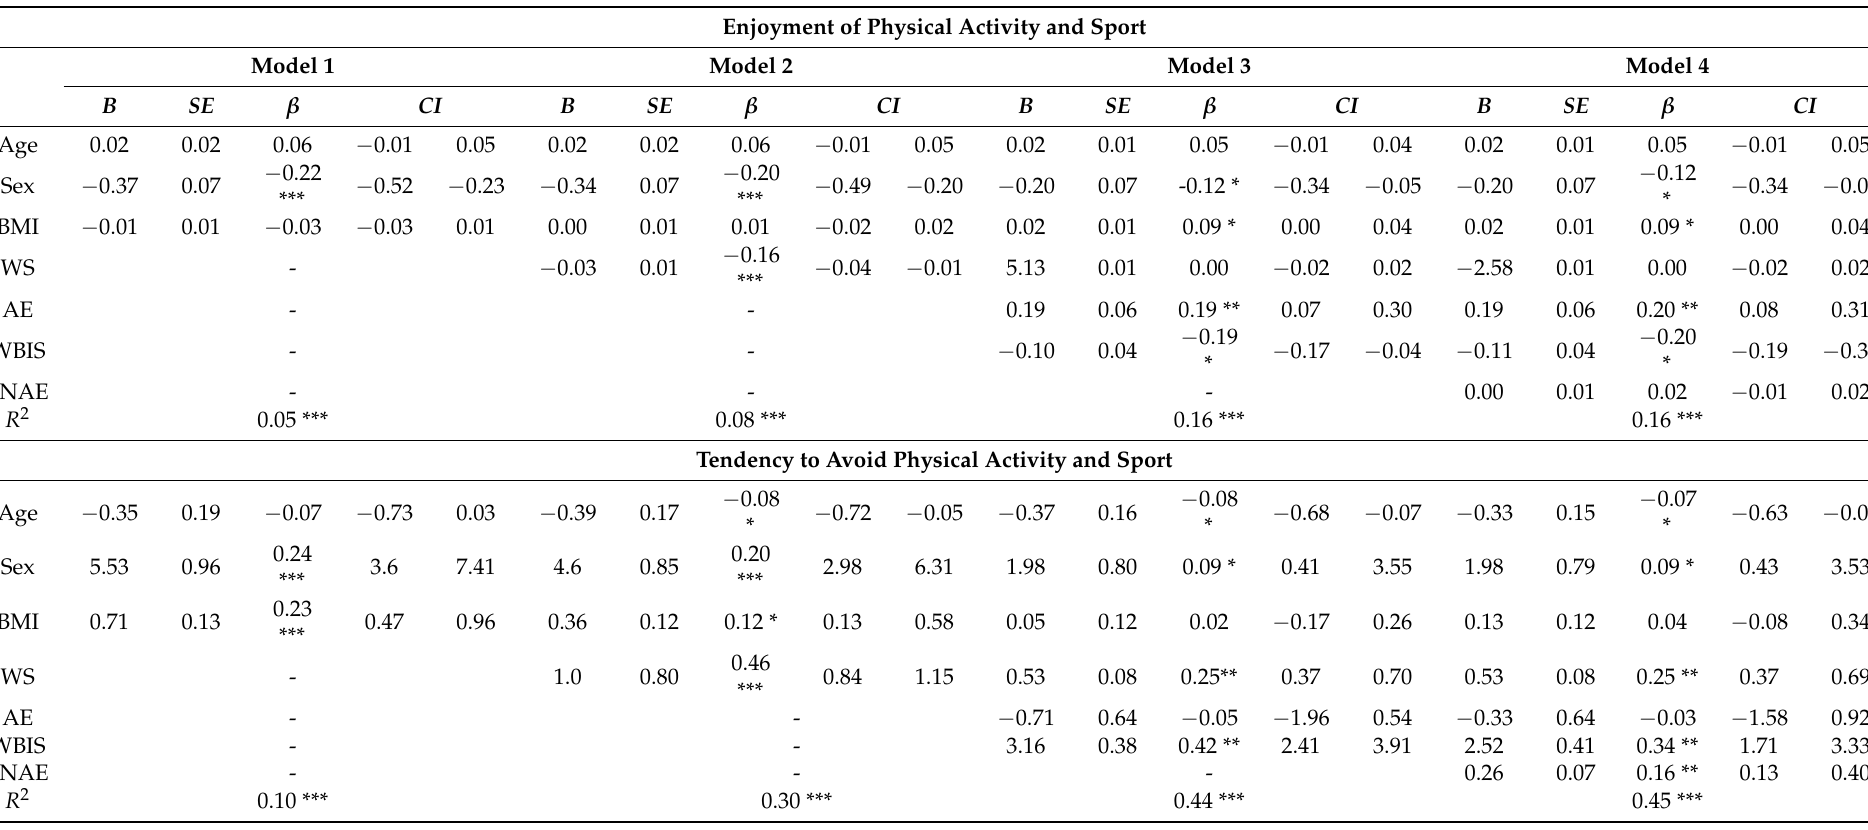
Table 3. Regression models reporting unstandardized ( B ) and standardized beta’s ( β ) and standard errors ( SE ) for predictors of the enjoyment of physical activity and sport, and the tendency to avoid physical activity and sport